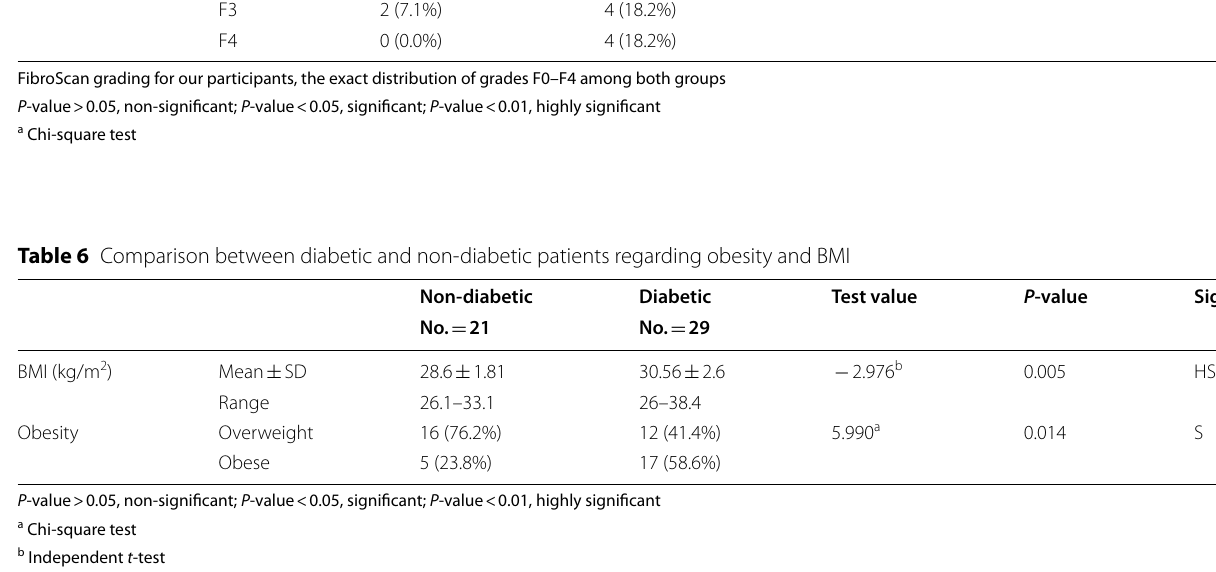
P -value > 0.05, non-significant; P -value < 0.05, significant; P -value < 0.01, highly significant a